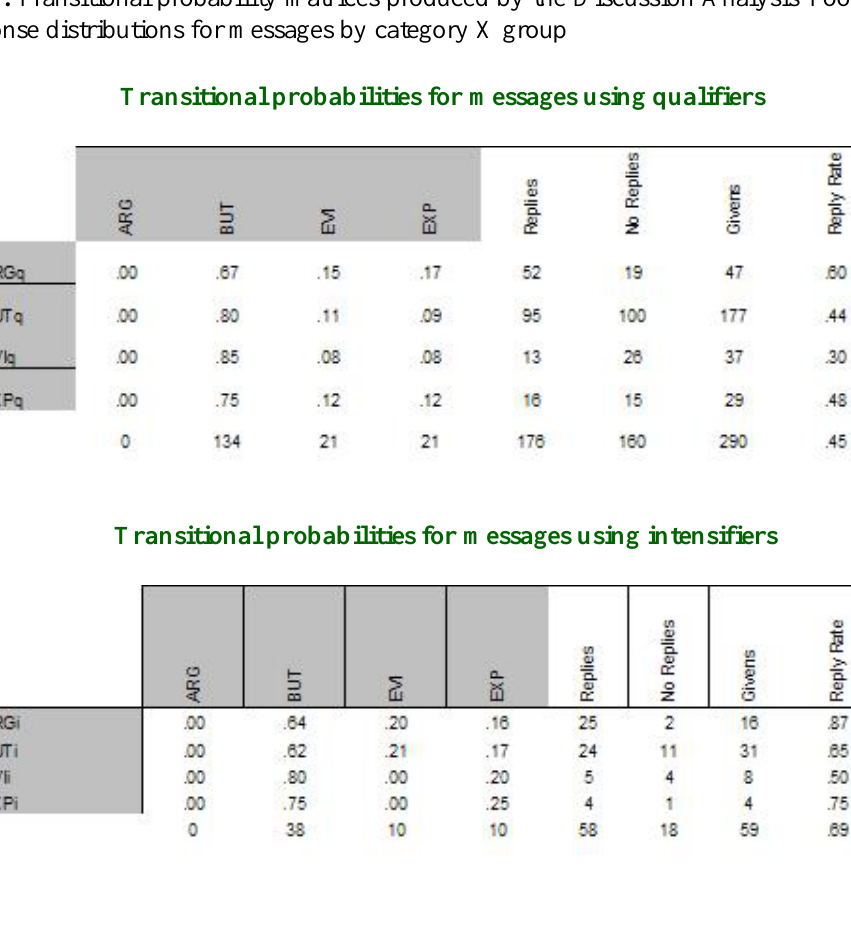
Figure 3. Transitional probability matrices produced by the Discussion Analysis Tool containing the response distributions for messages by category X